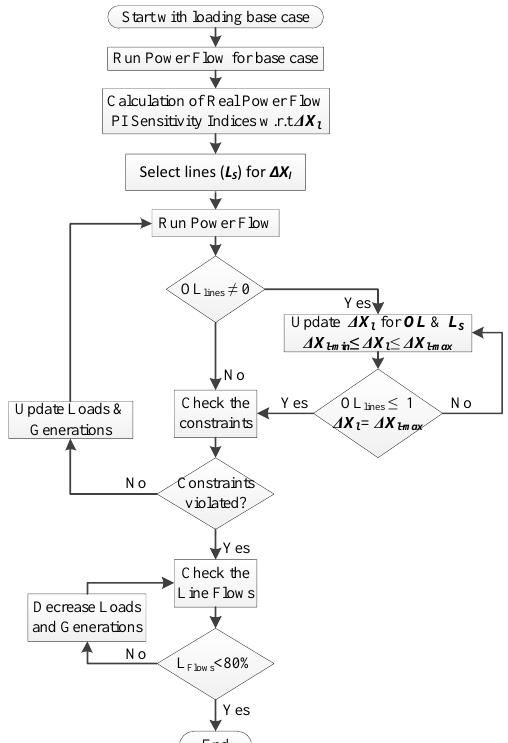
Figure 2. Flow chart of Proposed Method for TTC